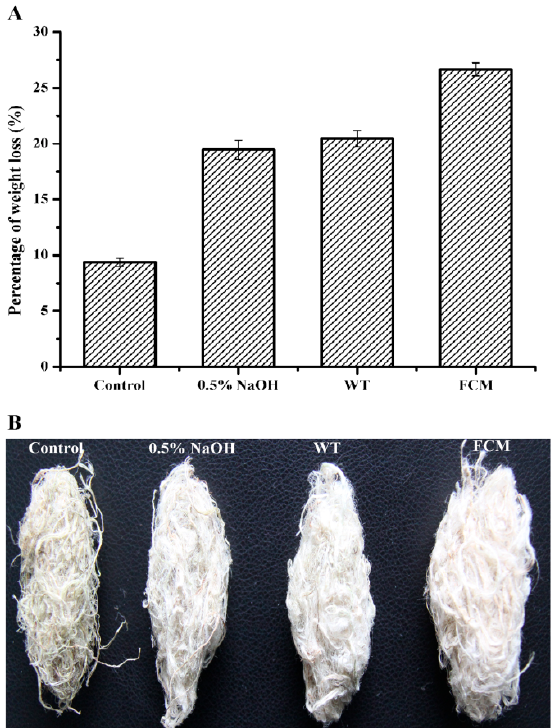
Figure 5. Percent weight loss and morphological image of degummed ramie fibers. ( A ) The ramie fiber weight loss. ( B ) The morphological image of degummed ramie fibers. FCM means the final combined mutant R150G/R216H/A238C. The weight loss measurements were performed in three independent experiments. Error bars represent standard deviations.